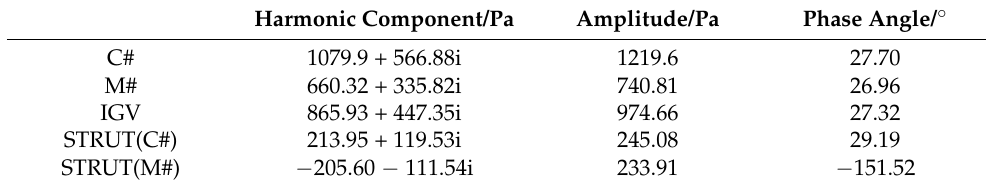
Table 4. The 54 EO component of total pressure at IGV/R1 interface.